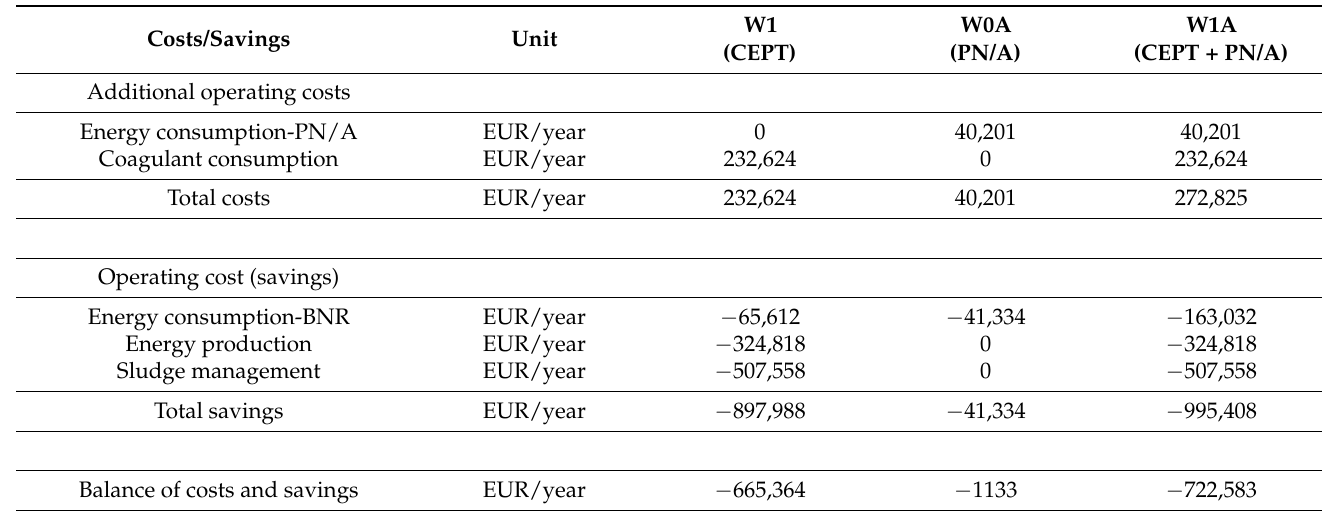
Table 7. Balance of costs and savings.